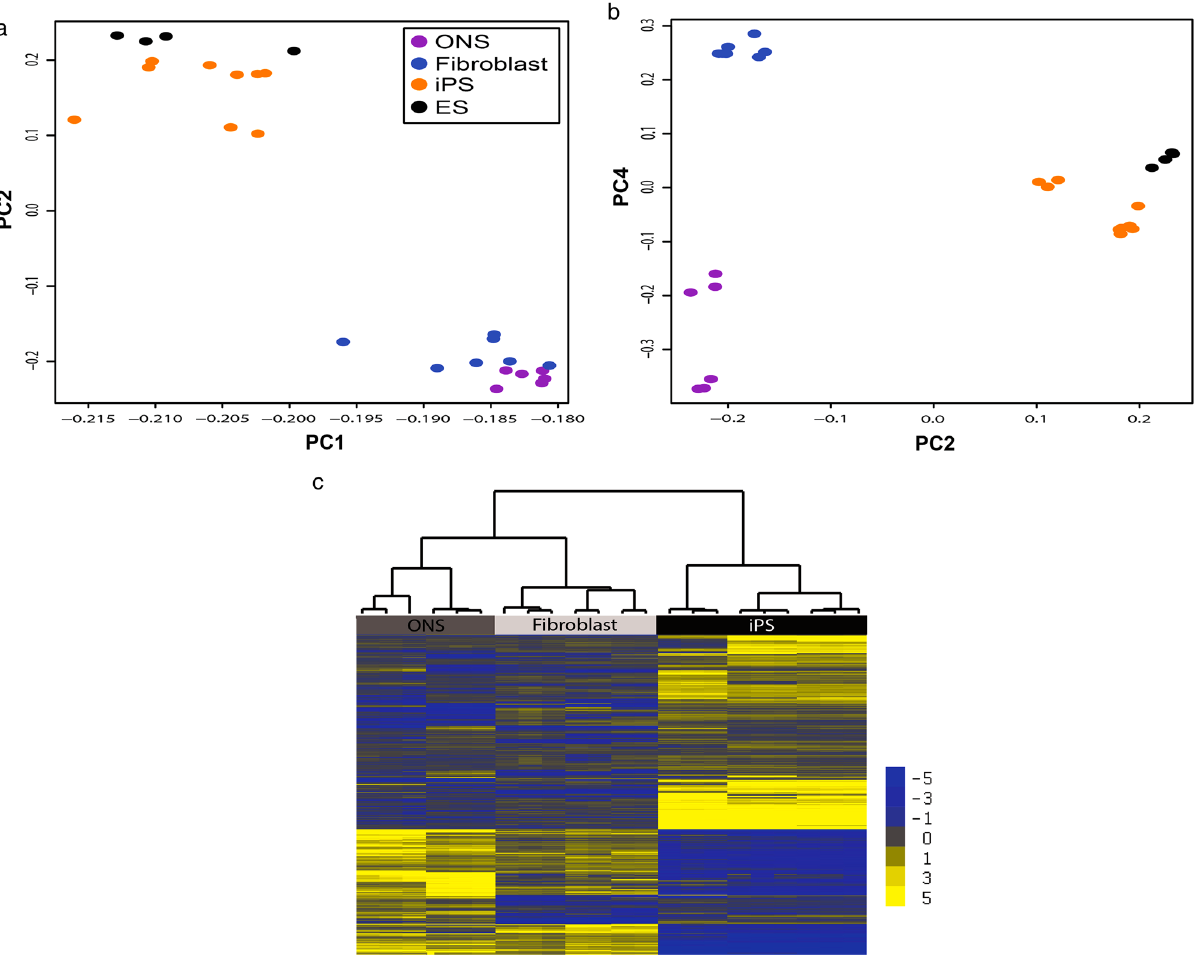
Fig. 1 Cell types have distinct DNA methylation pro fi les. a , b Unbiased PCA on all detected probes on array demonstrates that cell types are distinguished by DNA methylated gene loci. a Principal components 1 ( x-axis ) and 2 ( y-axis ) separate the pluripotent cells (iPS and ES cells) from the adult tissue-derived cells (ONS and fi broblasts). b Principal components 2 ( x-axis ) and 4 ( y-axis ) separate the three cell types from each other. c The individual cell lines separate into cell types after cluster analysis on the probes that were statistically different between the cell types ( p < 0.05, FDR correction). Gene loci are illustrated as horizontal yellow and blue lines scaled from the average, which is gray . Higher methylation than average is yellow . Lower than average is blue . Scale is on right. Statistical clustering similarity is shown by the tree diagram. iPS cells are distinctly different from the adult-derived cells (top branch). ONS and fi broblasts are also distinguished from each other (second branch on ( “ nodes ” in Fig. 3b) were connected by 374 different interactions ( “ edges ” ), with 1 – 30 edges per node (average 6). In Fig. 3 the size of the gene name is proportional to the number of interactions it has with other genes in the network, demonstrating the relative importance of those genes in the regulatory network. The differentially expressed genes with the greatest number of interactions were also those with the largest numbers of interactions with the differentially methylated genes ( purple and pink labels , Figs. 3a, b). Genes whose expression was increased in patient-derived cells ( yellow labels , Figs. 3a, b) were intercon- nected with hypomethylated genes ( purple labels ), whereas genes whose expression was decreased ( blue labels ) were interconnected with hypermethylated genes ( pink labels ).